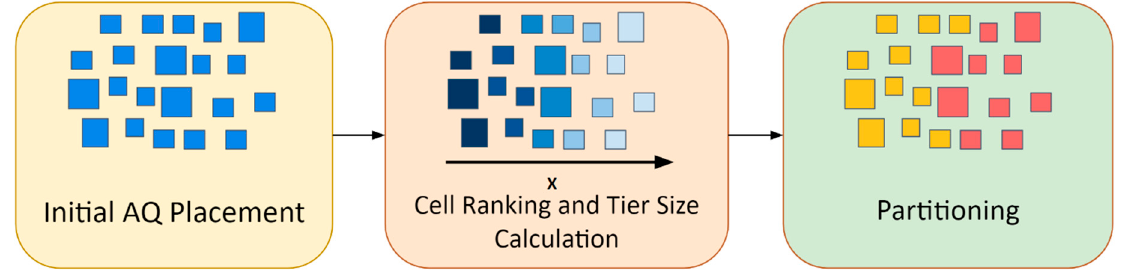
Figure 6. Example of tier partitioning. The red and yellow rectangles in the third window represent cells assigned to different tiers.